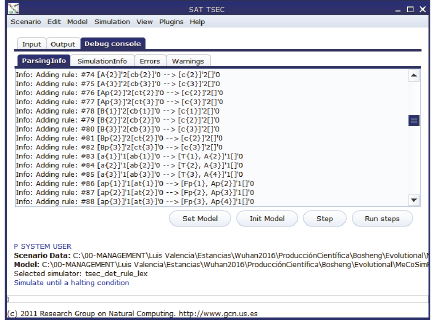
Figure 6: Debugging process.